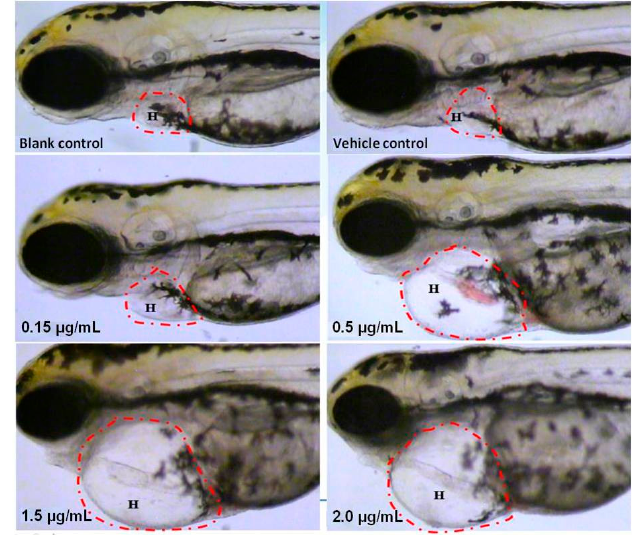
Figure 2. Visual observation of zebrafish larvae at 120 hpf after microinjection of SA at 72 hpf. The circled area (H) is zebrafish heart and pericardium.